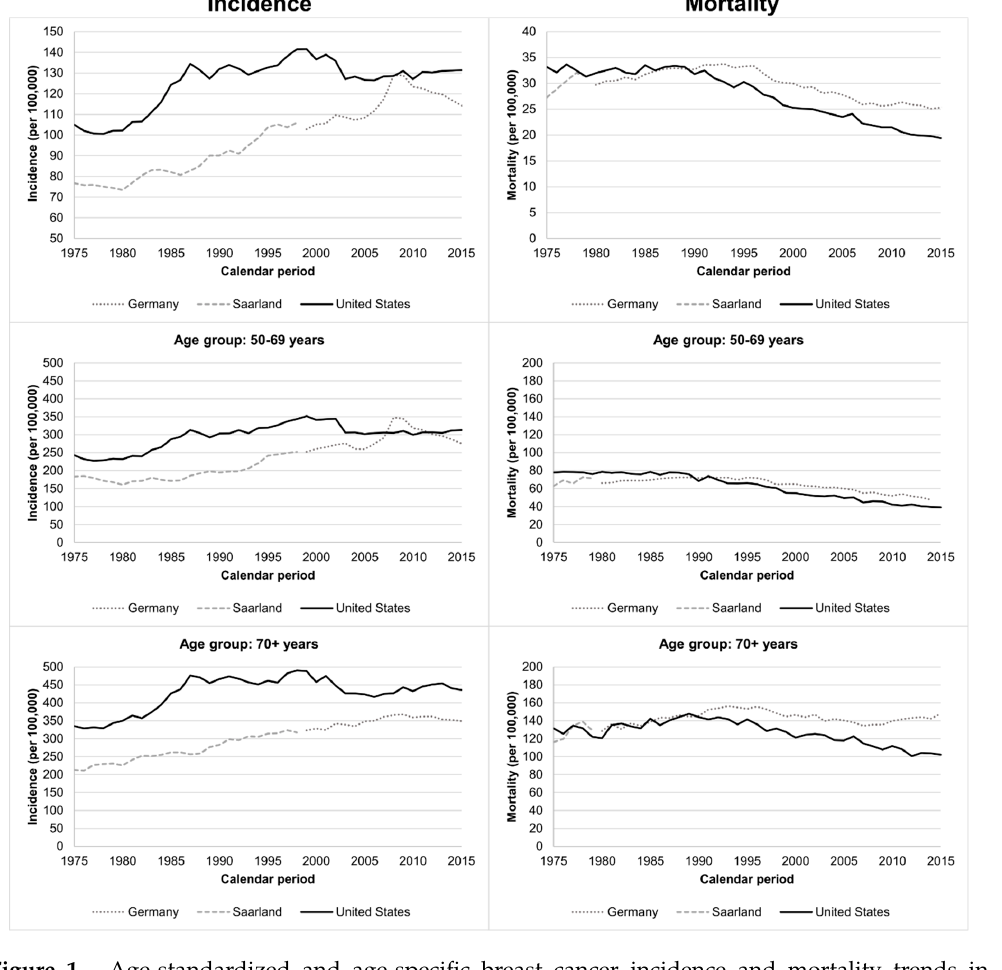
Figure 1. Age-standardized and age-specific breast cancer incidence and mortality trends in Germany / Saarland and the United